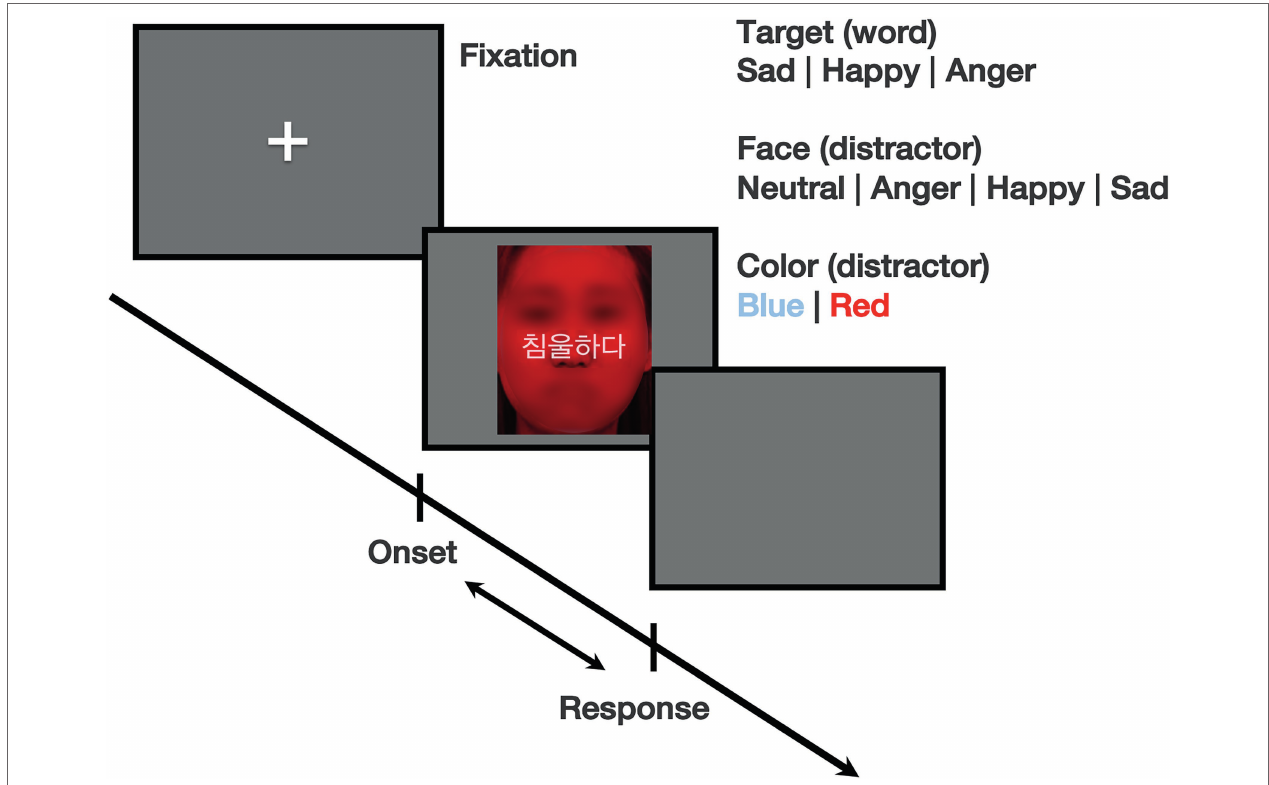
FIGURE 3 | Sequence of events for Experiment 2 (The face in the figure is selected from example photos of KOFEE and reprinted under permission based on consent of initial development study). The face is blurred following the ICMJE